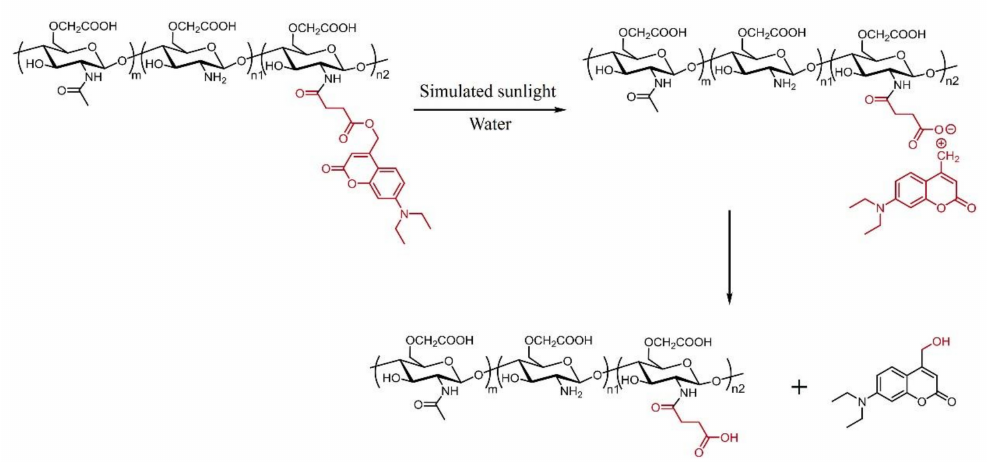
Scheme 2. Mechanism of the photolysis of the CMCS-DEACMS upon simulated sunlight.